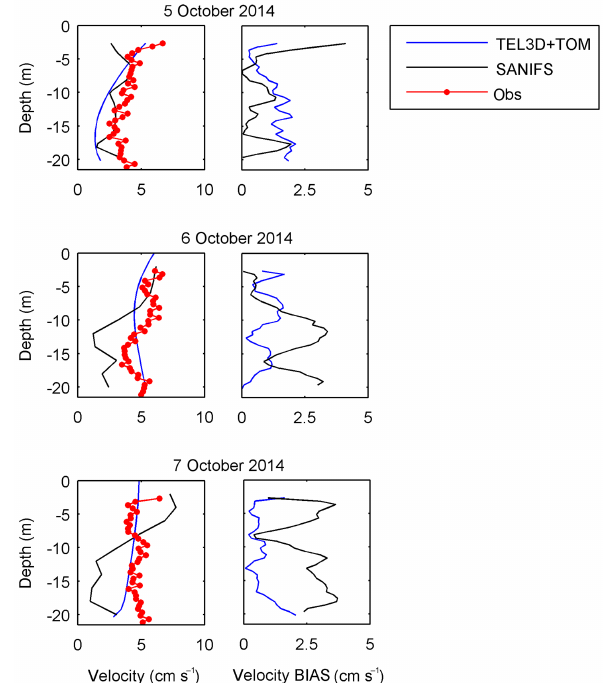
Figure 12. Daily-averaged vertical profile of current at the Mar Grande station and BIAS. Left panels: numerical results from the coupled TEL3D + TOM (blue line), SANIFS (black line) and obser- vations (red line and circle markers); right panels: continuous lines show the velocity BIAS for the two models over the water